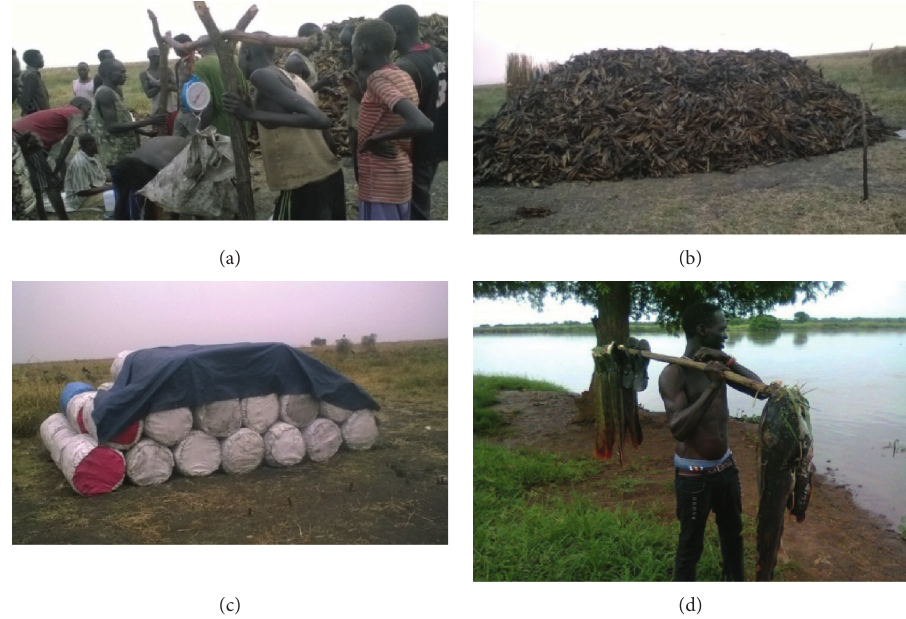
Figure 1: Fish marketing and transportation: fishers selling their dried fish to the local enterprises at the landing site (a); dry fish ac- cumulated by the enterprises after being bought (b); dry fish are packed and made ready to be transported to big towns and cities (c); fisher carrying his catch to the nearby local market (d) (photos by Gatriay